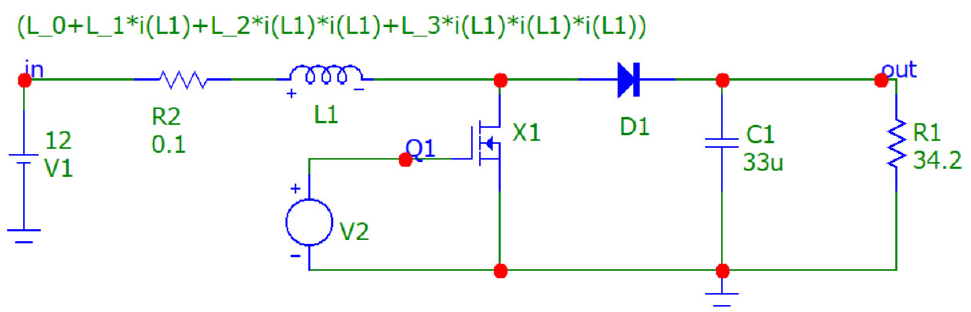
Figure 12. DC/DC boost converter implementation in Micro-Cap Spice simulator with a non-linear inductor implementing the polynomial model.